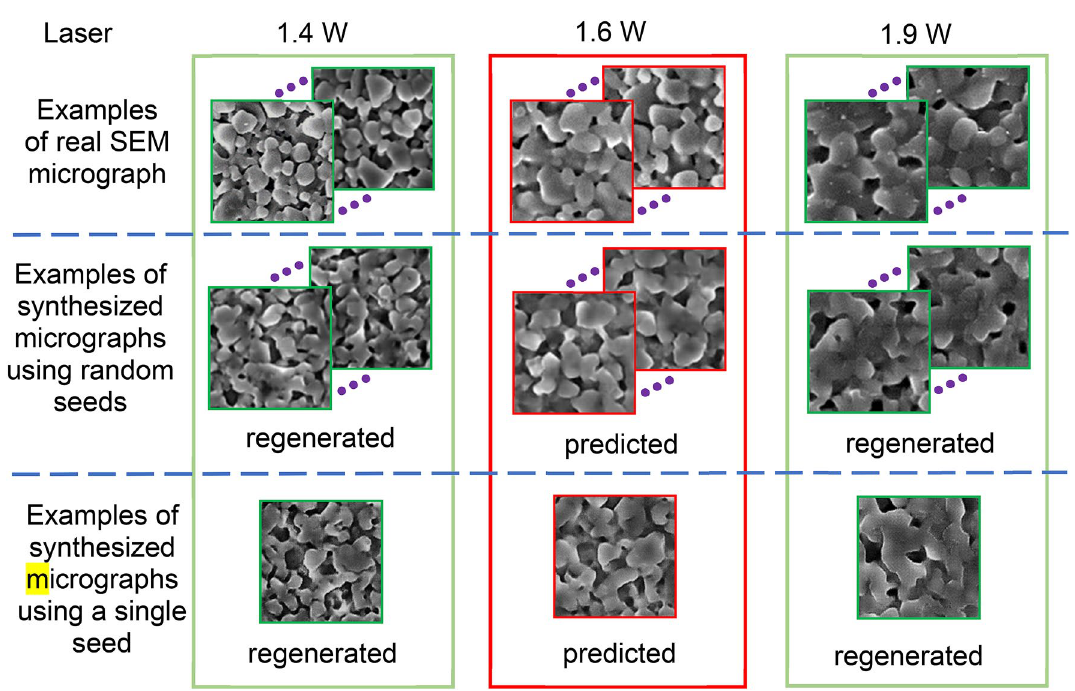
Figure 3. The examples of regenerated and predicted SEM micrographs using the RCWGAN-GP. For the laser power 1.6 W highly imitate the real SEM micrographs, in terms of microstructural features such as particle and pore morphologies